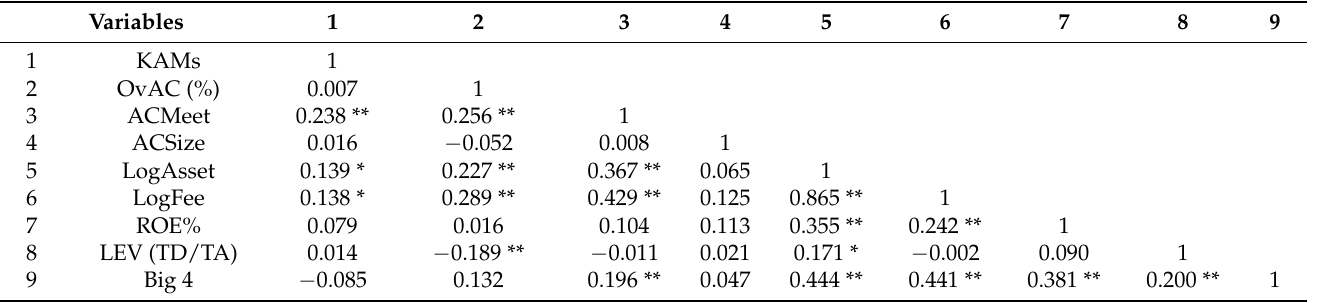
Table 2. Pearson’s Correlation Analysis.